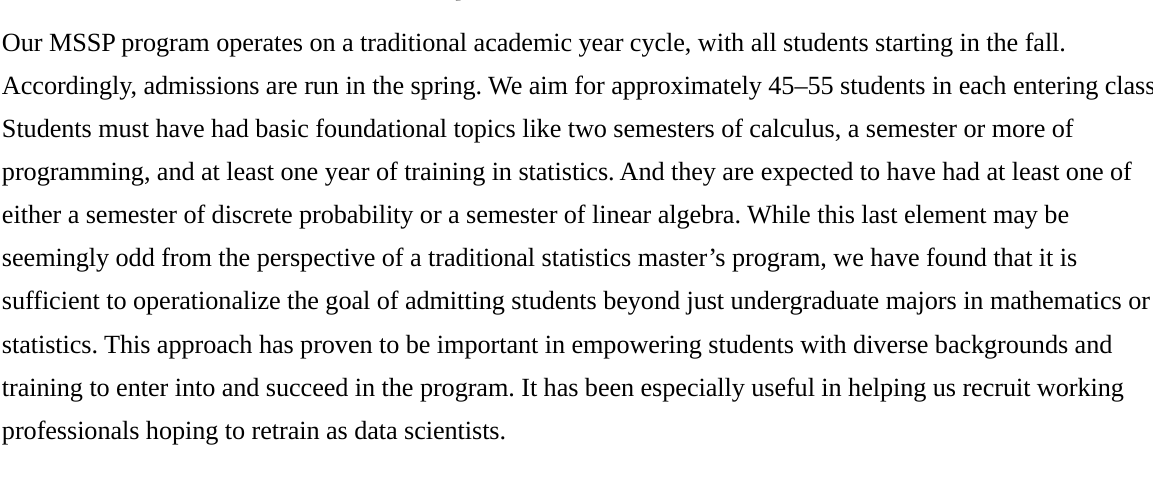
Table 1. Summary of personnel used in offering the statistics practicum to the current steady- state of ~50 students per